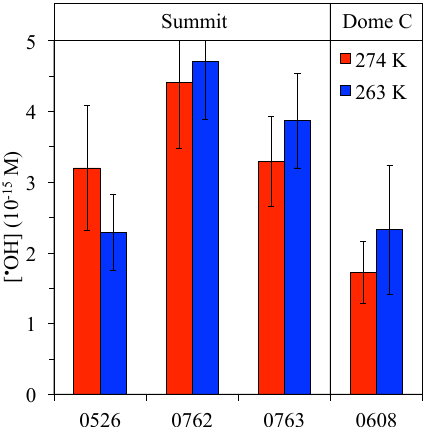
Figure 5. Laboratory-determined steady-state • OH concentrations in Summit and Dome C snow samples at 274K (red) and 263K (blue). Error bars represent ± 1 standard error, based on propagated errors in the slope and y intercept of the “inverse”